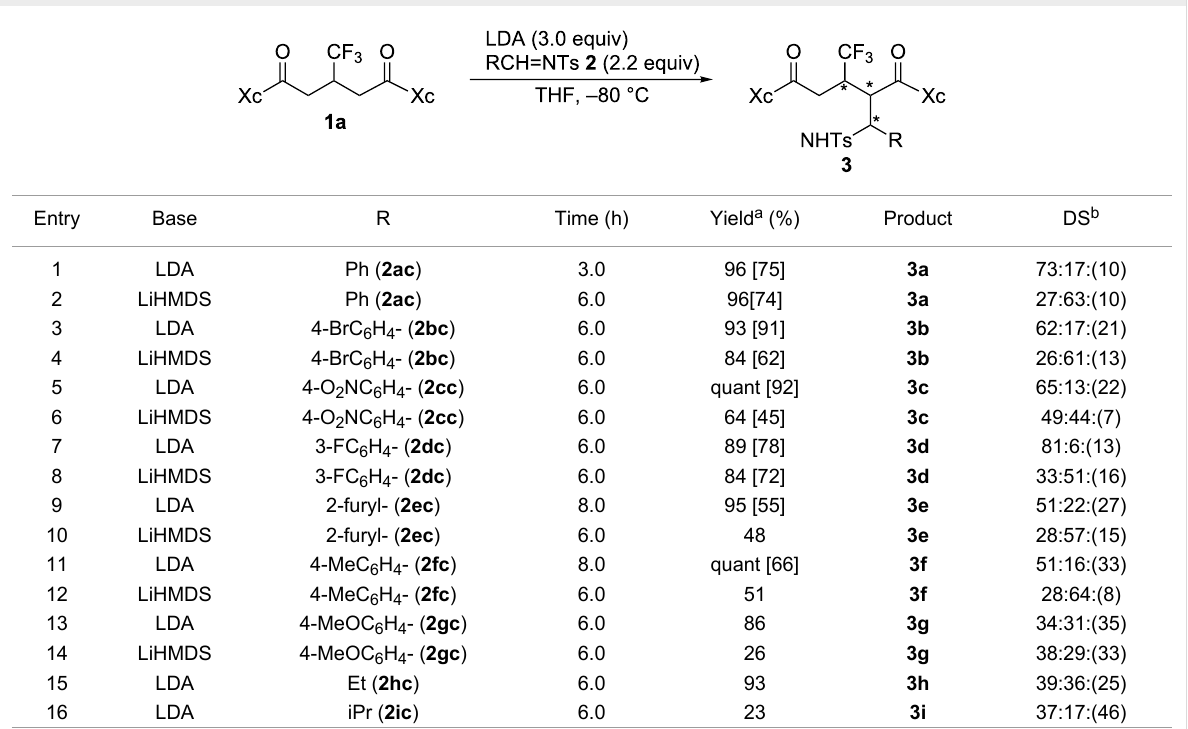
Table 2: Scope and limitation of the present Mannich reactions.